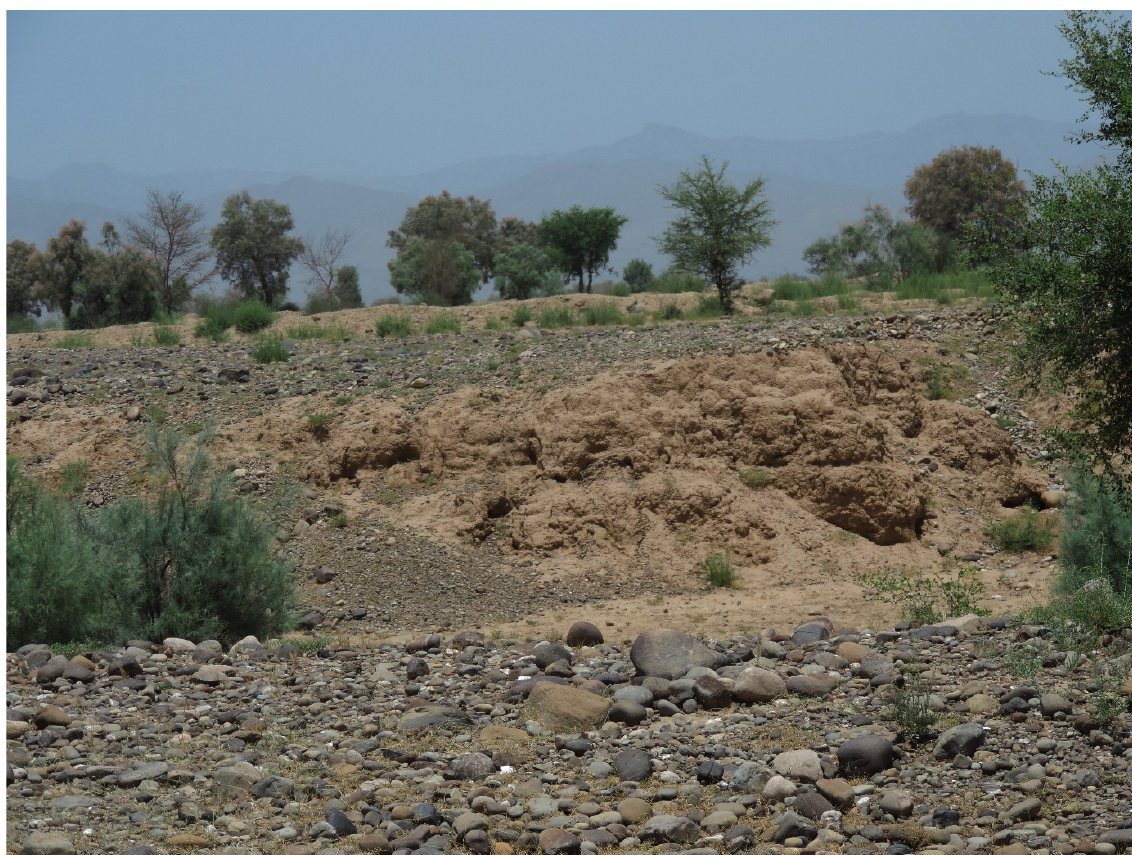
Figure 3 A thick deposit of silt of alluvial origin covered with a layer of dark grey and black varnished gravels south of the course of Barrai Khuarra (photograph by R. Nisbet, 2019).